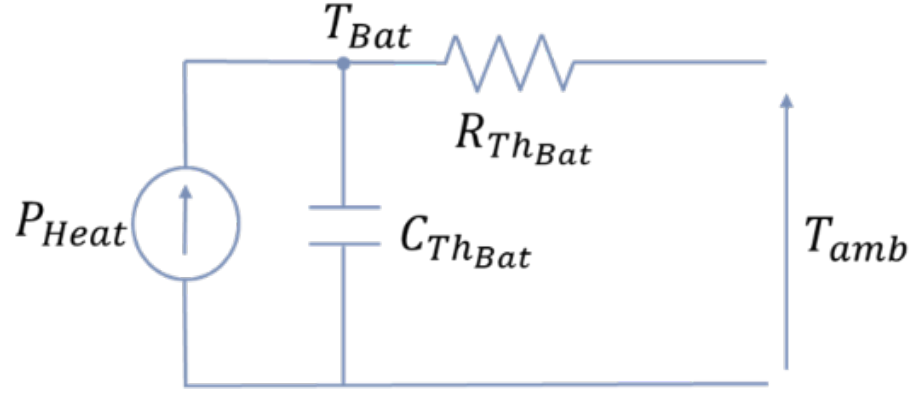
Figure 3. Battery thermal model.